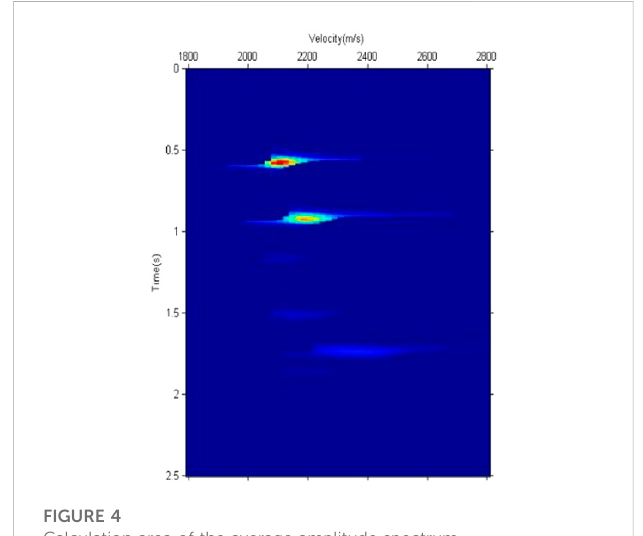
FIGURE 4 Calculation area of the average amplitude spectrum.